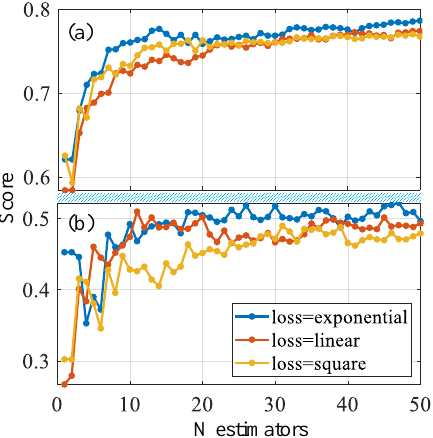
Figure 5. Different loss function score curves: ( a ) training set and ( b ) testing set.